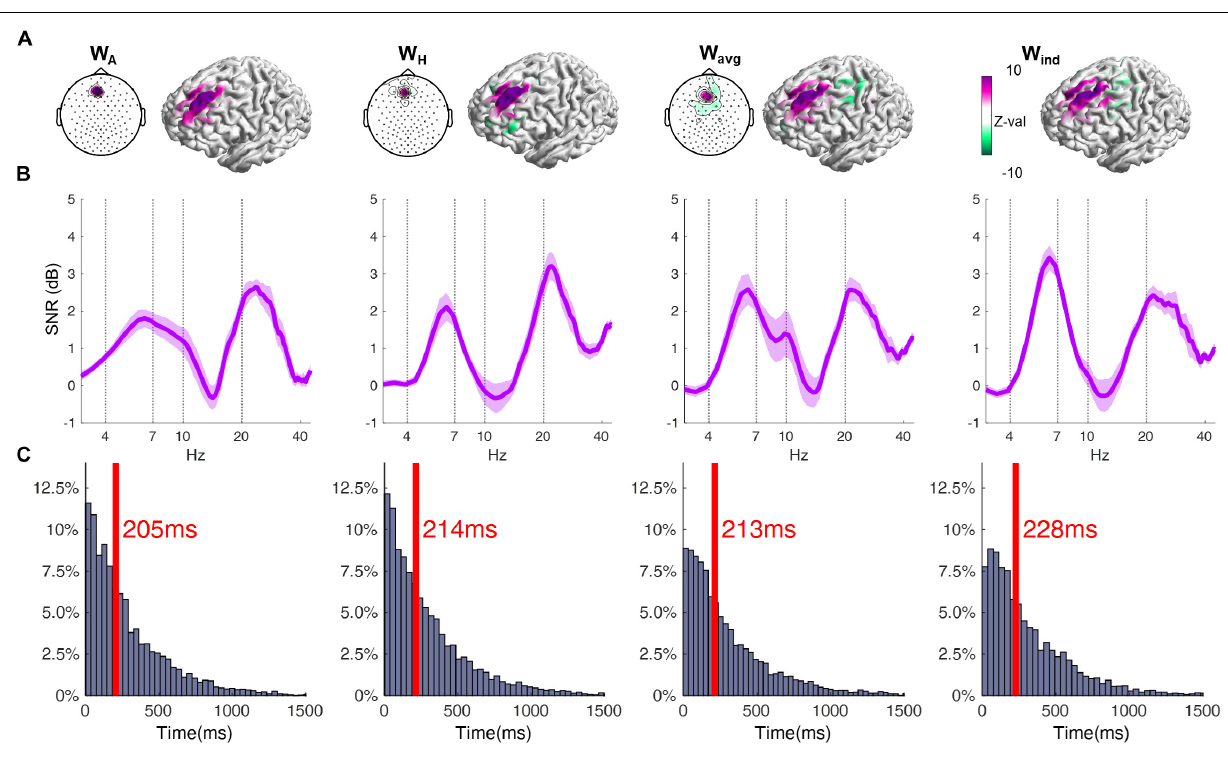
FIGURE 2 | (A) Topographical plot displaying the EEG channels’ coefficient weighs of the respective filter. Cortical surface plots show the sensitivity profile of the respective filter, averaged across all subjects. The coefficient weights are given in arbitrary units, and are here normalized across all individuals using the standard score (z-value). Note that for the W ind filter the values are different for each subject, and its average is depicted in W avg . Also, results using the W ind filter involved the application of the individual filter for each subject, and thus cannot be shown as a single topographical plot. (B) Power spectra of the resting-state EEG signal, obtained by using the respective spatial filters, averaged across all subjects (shaded area corresponds to ± 1 SEM). Data is depicted in form of Signal-to-Noise-Ratio. (ANOVA, p = 0.0055; post-hoc W A = W H < W ind ). (C) Distribution of the time lengths of epochs between phase slip events of the theta oscillation. Red line and text indicate the median of the respective distribution (ANOVA, p = 0.0009; post-hoc W A < W H = W avg < W ind